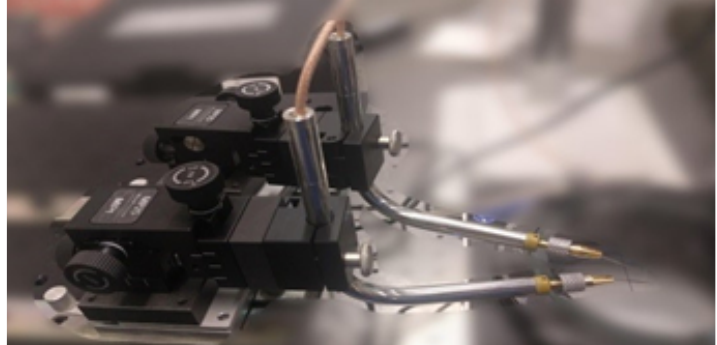
Figure 3. The two micropositioners with probe arms and tungsten